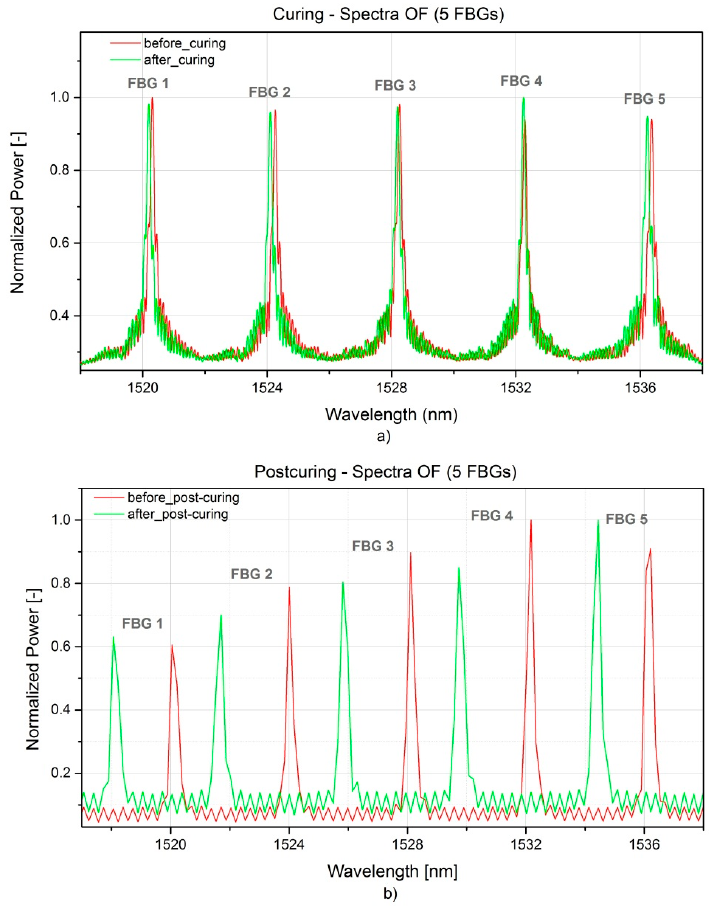
Figure 9. FBG spectra acquired during RTM production ( a ) and post-curing ( b ) of the A380 hinge